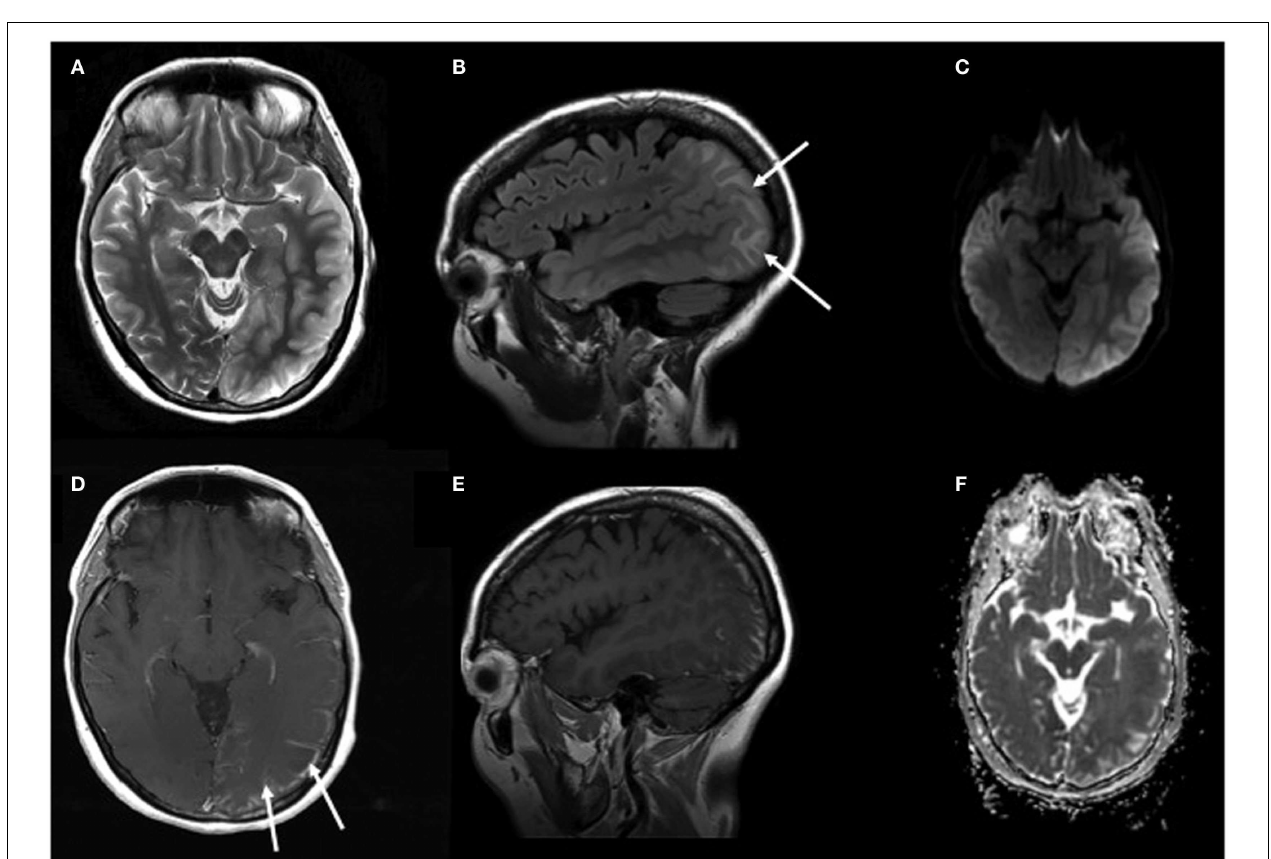
FIGURE 2 | MRI of the brain on day 24 of PRES . Images show axialT2 (A) and sagittal FLAIR (B) with cortical edema andT1 with contrast enhancement (D,E) of the leptomeninges. Right column images show DWI (C) and ADC (F) with vasogenic edema, but without areas with restricted